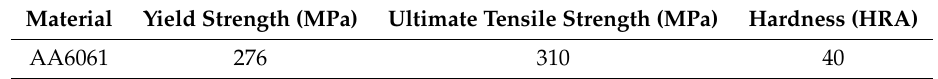
Table 2. Mechanical property of AA 6061 material.